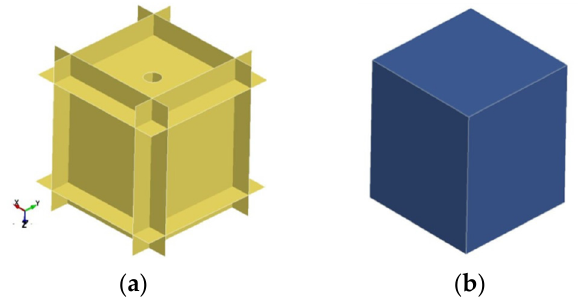
Figure 1. Calculation model [6]. ( a ) Box structure and coordinate; ( b ) Air domain.